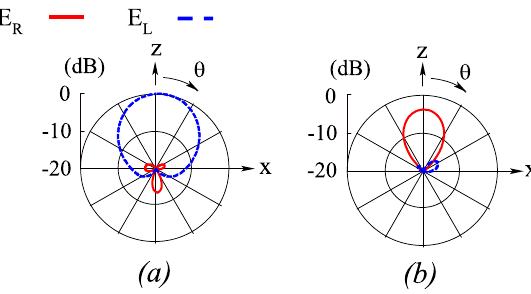
Fig. 16. Normalized radiation pattern for the round metaloop-N antenna. (a) At 2.575 GHz near f N1 = 2.55GHz. (b) At 3.5GHz near f H1 =3.425 GHz.